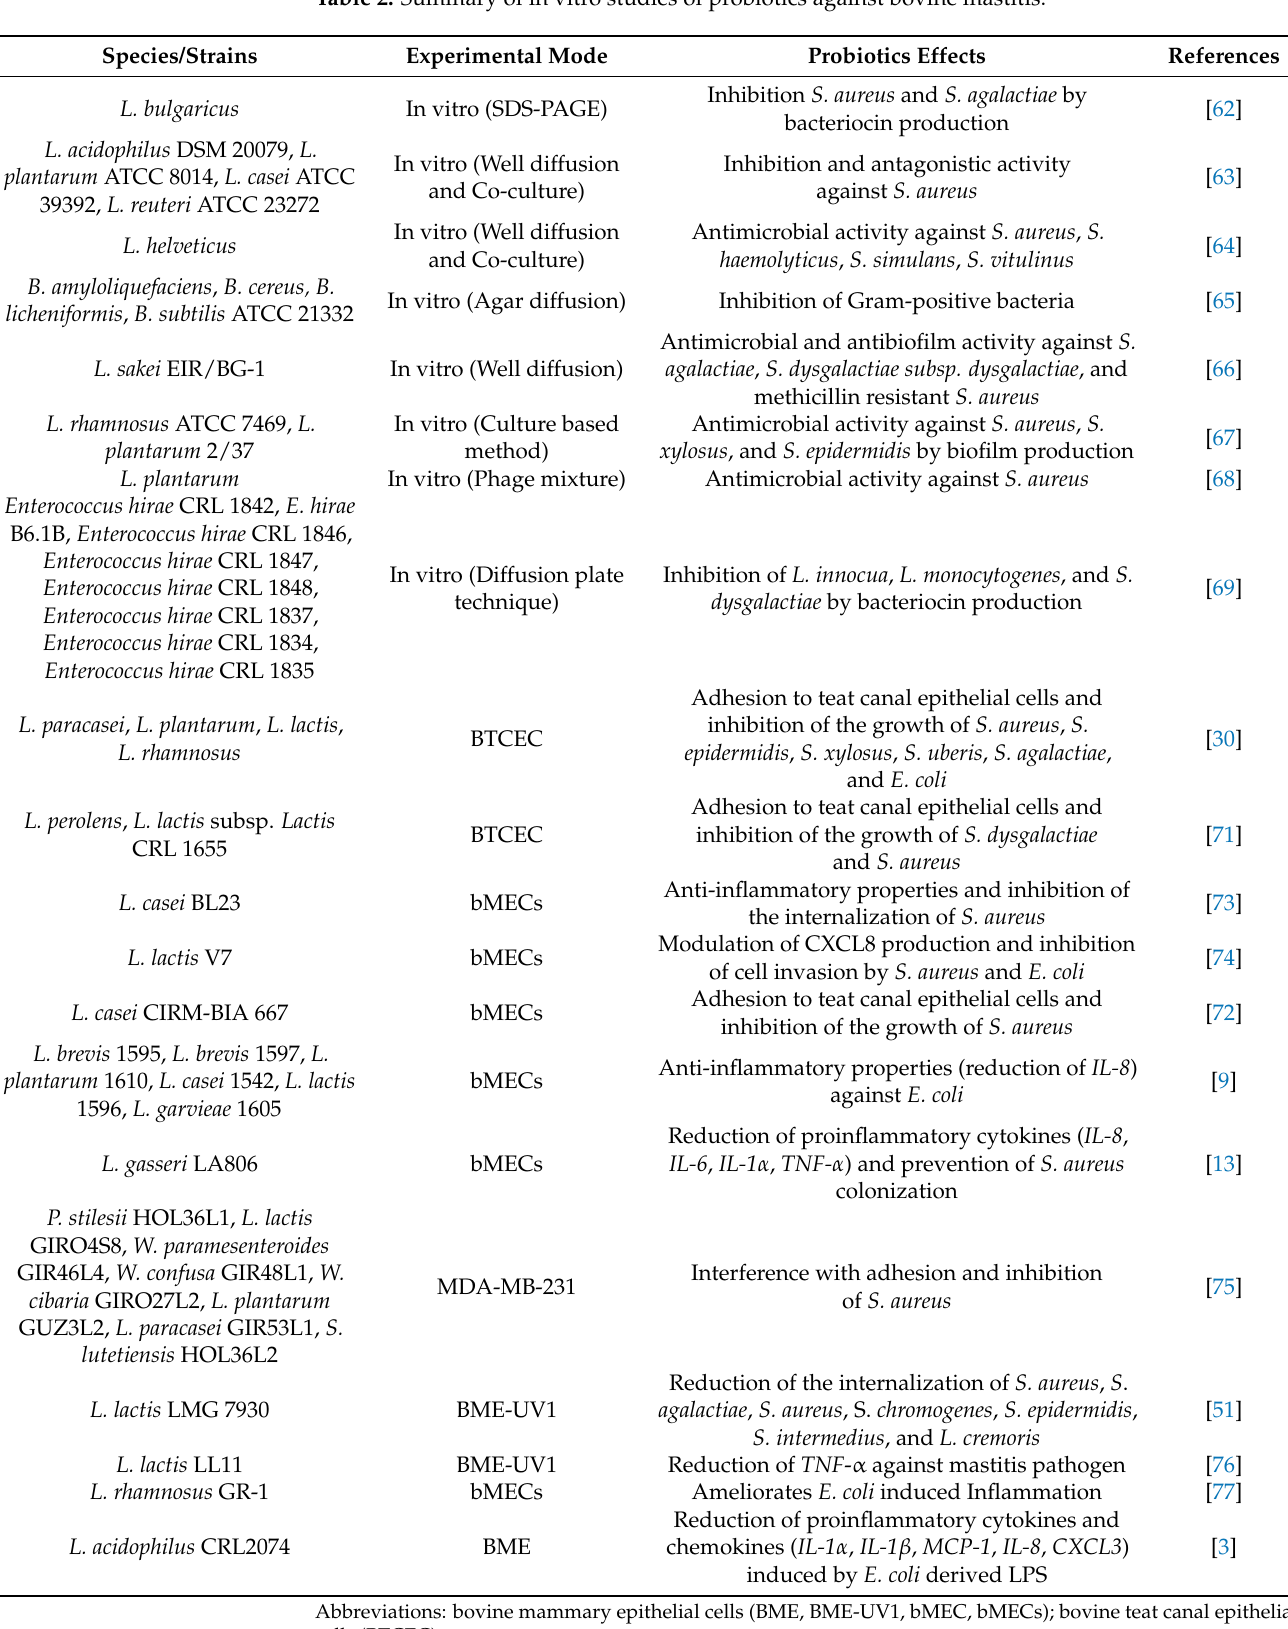
Table 2. Summary of in vitro studies of probiotics against bovine